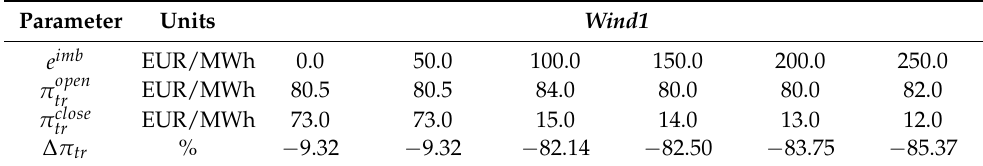
Table 5. Effect of information asymmetry of imbalance price for agent Wind 1 on transaction prices.